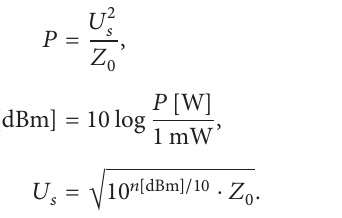
Figure 4: Radiation pattern of PICC antenna on 266MHz. Antenna behaves as a small magnetic loop antenna. Maximum gain is in the plane of the antenna.